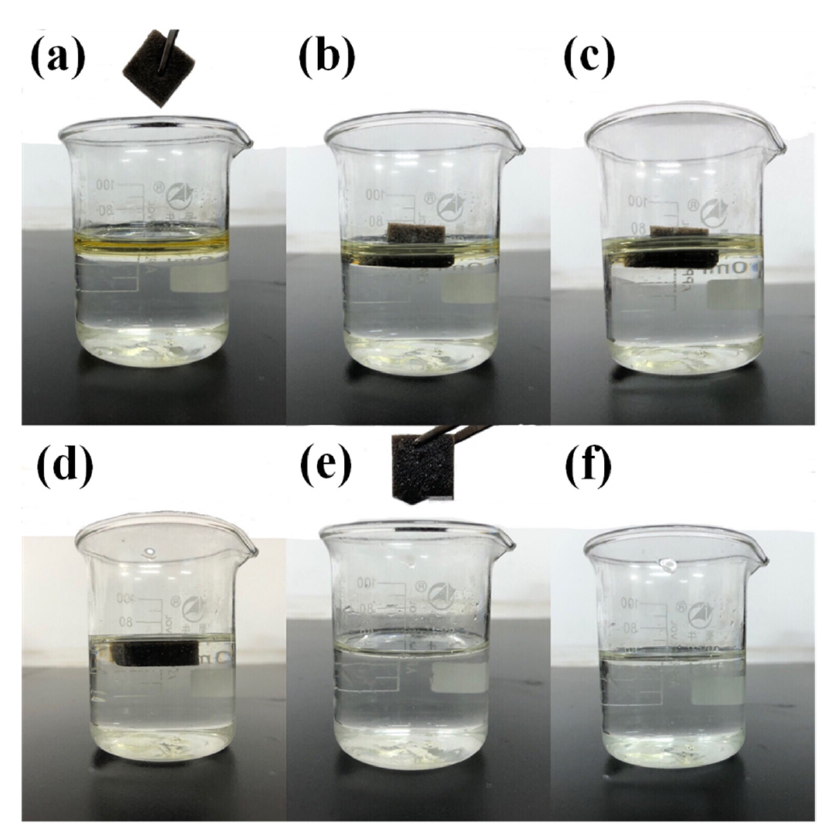
Figure 7. Digital photographs ( a – f ) show the oil-water separation process of composite sponge sample 2.